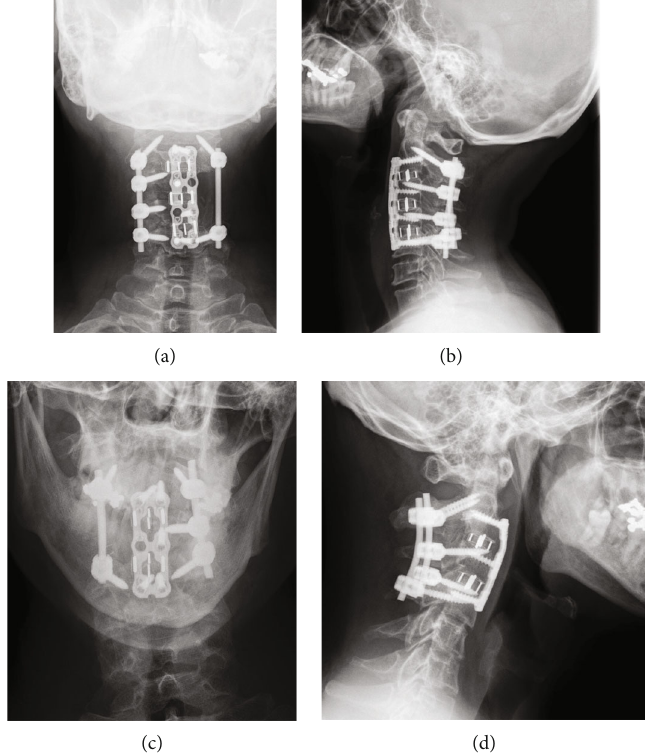
Figure 5: Follow-up. (a, b) a.p. and lateral radiographs of the cervical spine of case 1 at 12 months postoperatively. (c, d) a.p. and lateral radiographs of the cervical spine of case 2 at 4 months